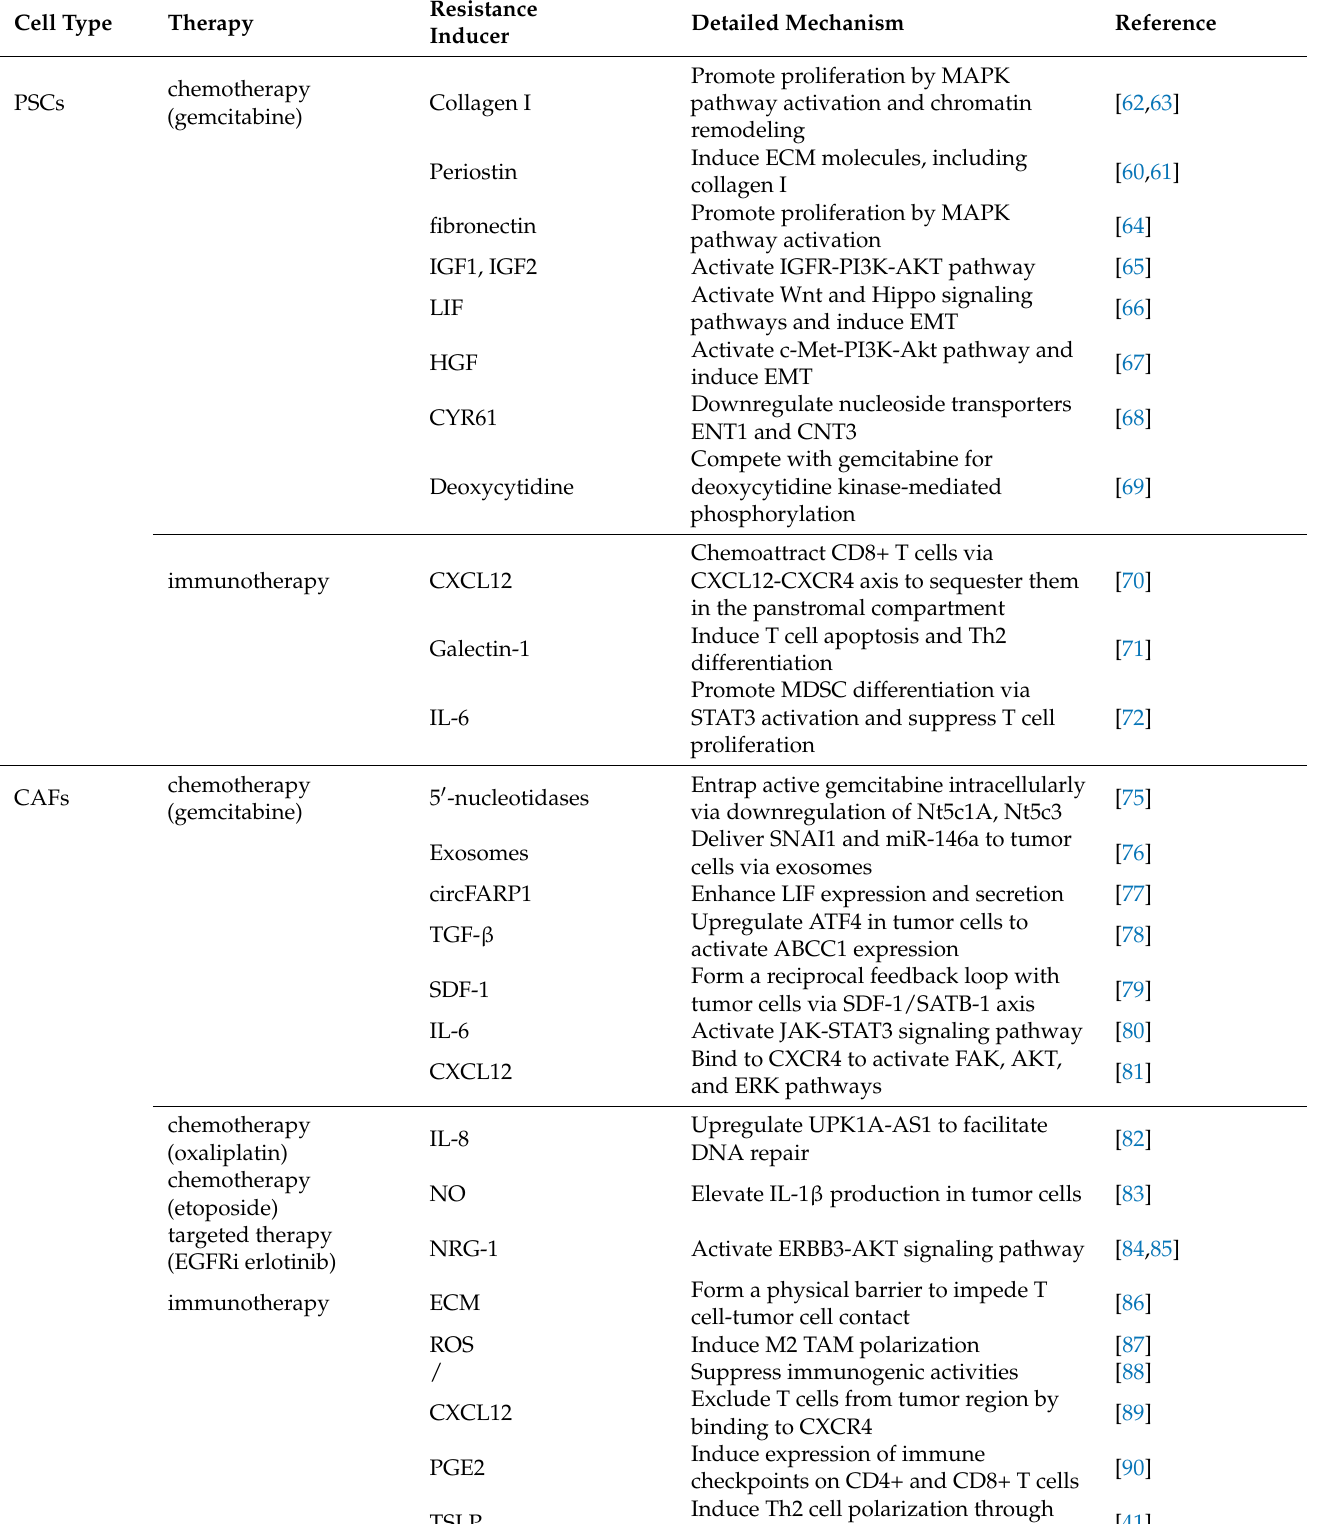
Table 1. Summary of therapy resistance mechanisms driven by tumor microenvironment in pancre- atic